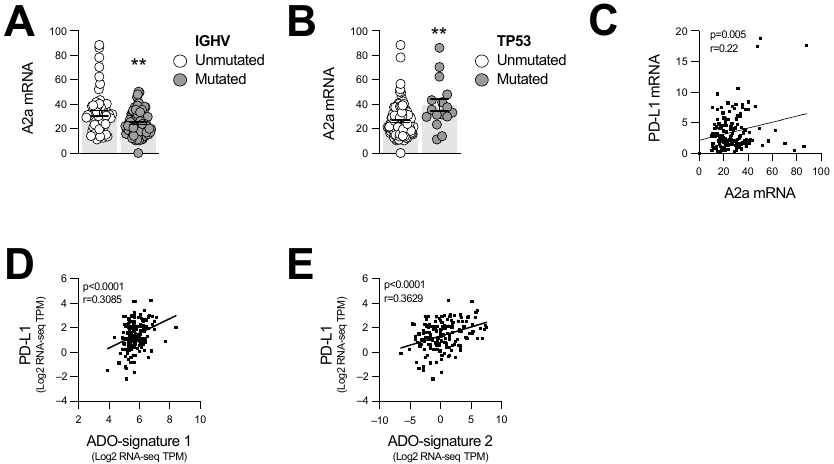
Figure 6. ADORA2A gene expression is associated with PD-L1 levels and increased risk stratification. Gene expression profile and mutation information data from 156 CLL patients, publicly available through the cBio Cancer Genomics Portal, were used to compared mRNA levels (RNA-seq TPM) of A2a (ADORA2A) between high- and low-risk patients. ( A ) A2a gene expression levels in IGHV- mutated (low risk; n = 92) and -unmutated (high risk; n = 59) patients. ( B ) A2a gene expression levels in TP53-mutated (high risk; n = 16) and -unmutated (low risk; n = 140) patients. ( C ) Correlation between A2a and PD-L1 gene expression. ( D , E ) Correlations between PD-L1 mRNA and adenosine gene signatures published by ( D ) Sidders et al. [26] (ADO-signature 1) and ( E ) Fong et al. [27] (ADO- signature 2). Means +/ − SEM are shown (** p < 0.01; by Mann–Whitney test ( A , B ) and Pearson correlation ( C – E )). TPM, transcript per